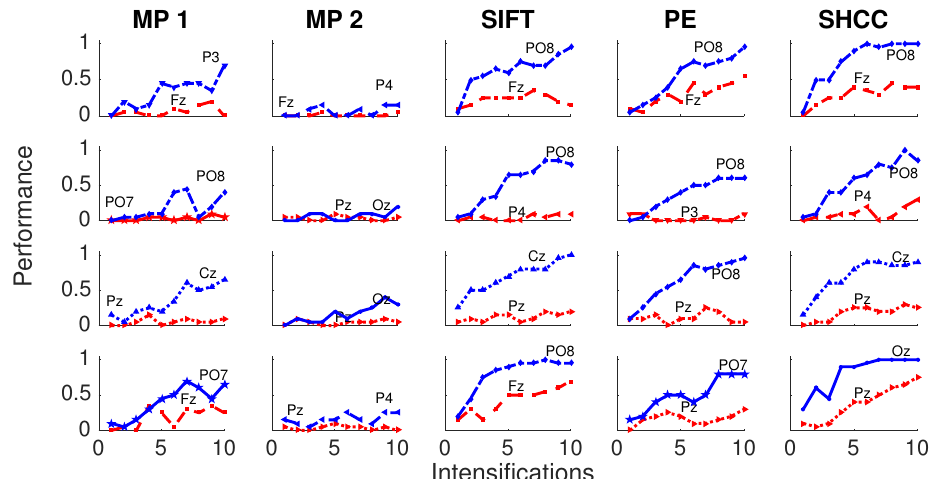
Figure 6. Passive Modality—Experiment 1: Speller performance curves obtained for each method for the four subjects that performed the passive modality protocol. Y-axis shows performance accuracy while X-axis shows the number of intensification sequences used to calculate the point-to-point signal average. The two curves show the performance for the best and worst performing